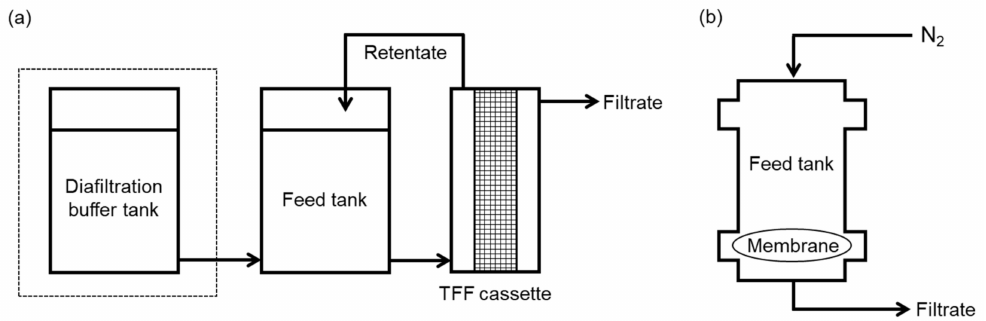
Figure 1. Schematic diagram of diafiltration and ultrafiltration using either ( a ) tangential flow filtration system or ( b ) normal flow filtration